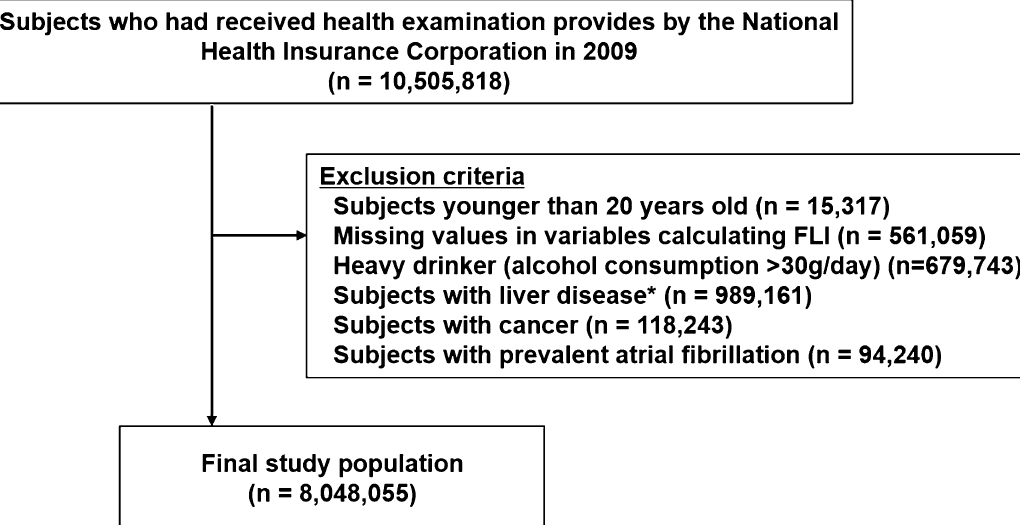
Figure 1. Study enrollment flow. *Liver disease: obvious liver disease such as liver cirrhosis (ICD-10 codes, K703 and K76) and hepatitis (ICD-10 codes, B15–B19), (v) existing cancer (ICD-10 codes,